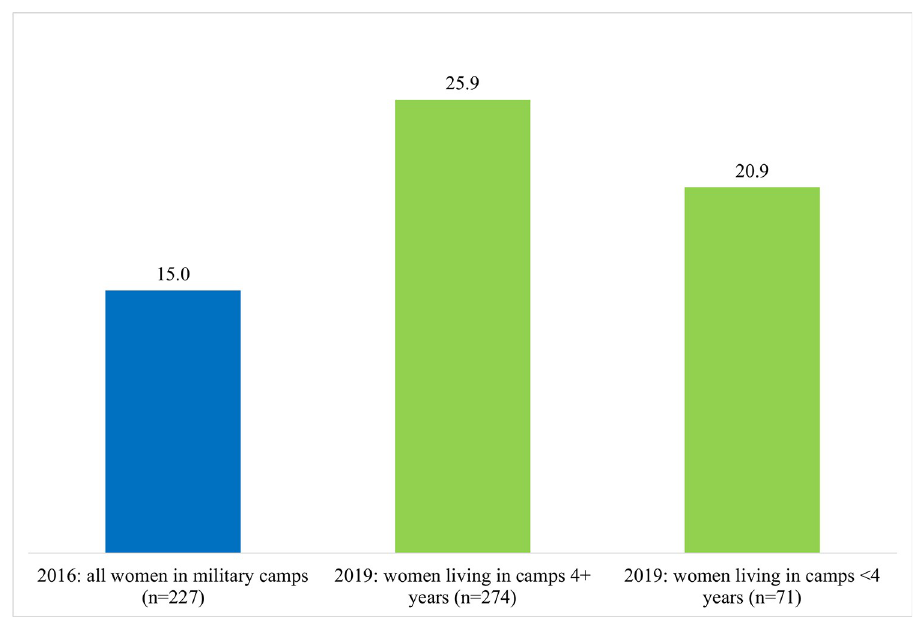
Fig 2. Differences in modern contraceptive prevalence between surveys by length of residence in the military camps (military women